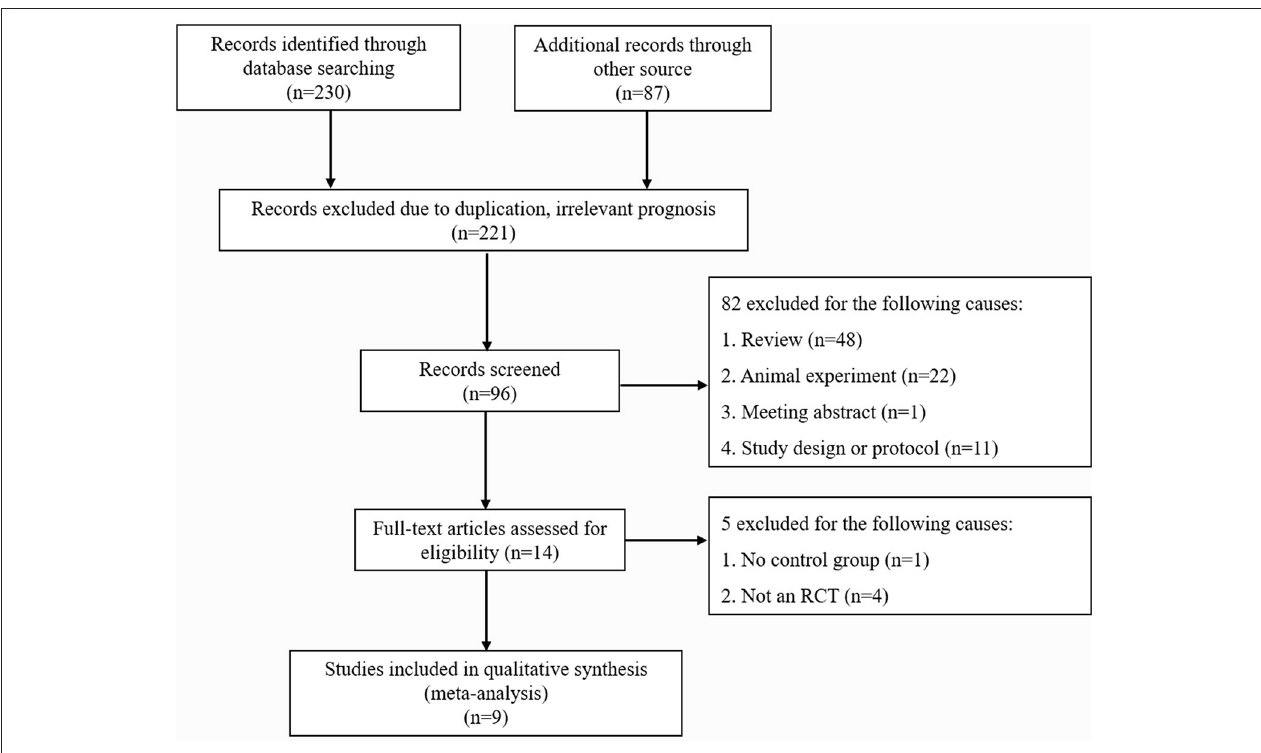
FIGURE 1 | Literature search and